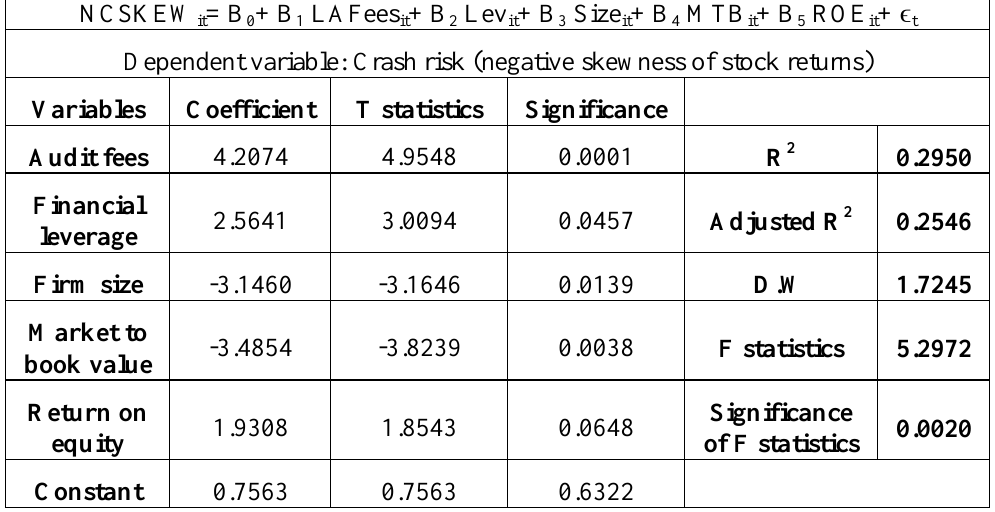
Table 3. Findings of the estimation of the regression model for the hypothesis testing